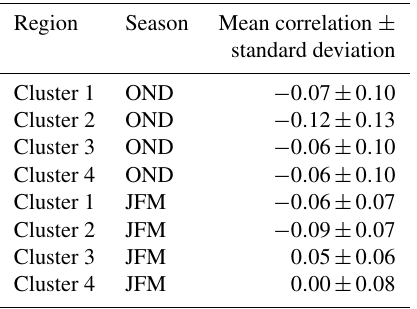
Table 6. Mean and standard deviation of 1979–2016 GLDAS soil moisture correlation with the Niño-3.4 index for the same regions shown in Table